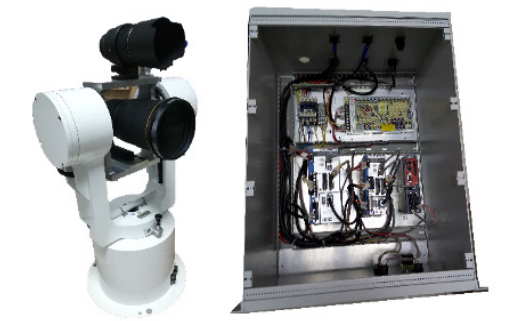
Figure 2. Material object of the turntable.